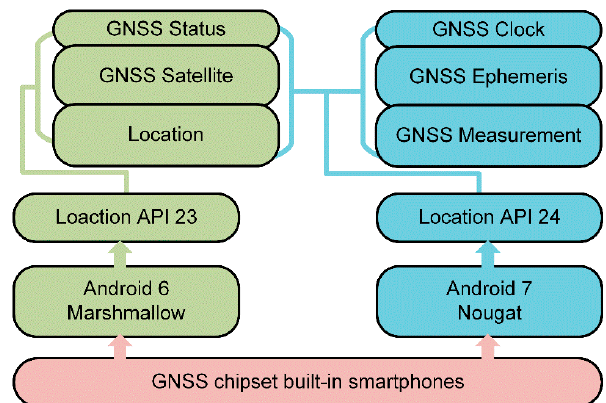
Figure 1. The comparison of the structures of location applications programming interface (API) 23 and location API 24.